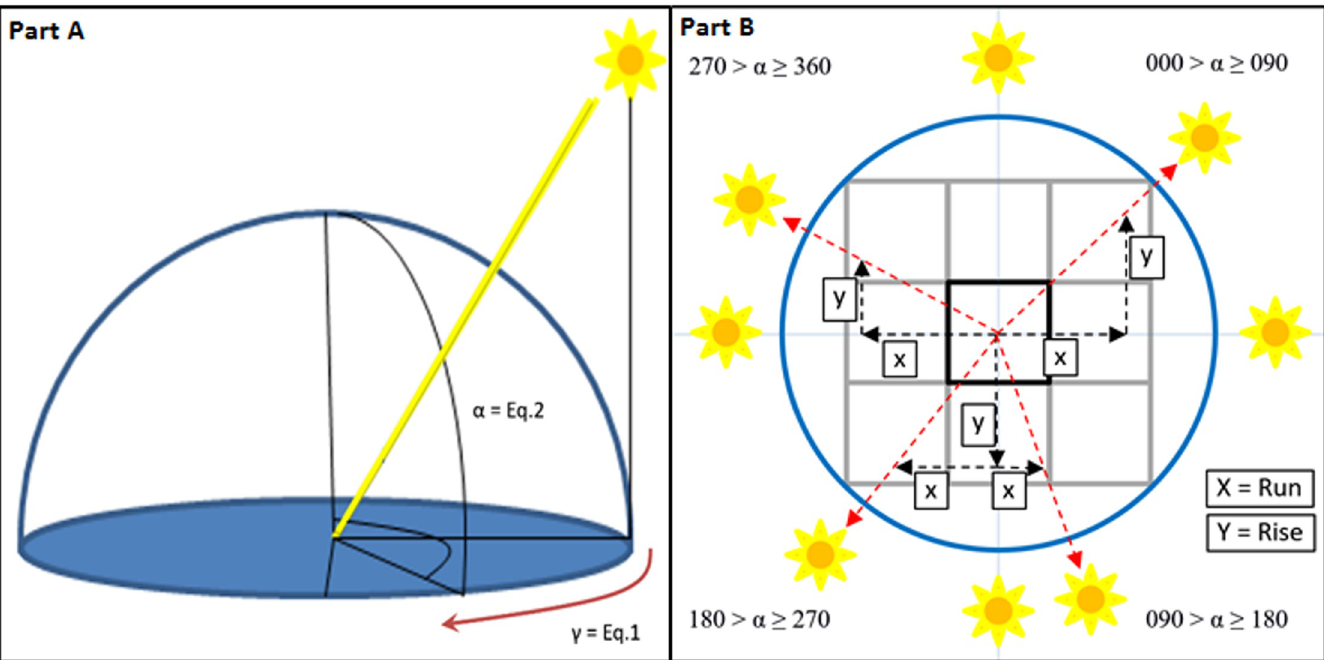
Fig 3. Solar angles and the walking algorithm . Solar azimuth ( α ) and altitude ( γ ) are calculated to control the direction the walking algorithm traverses the landscape. The walking algorithm azimuth rise (Y) and run (X) conversions with example sun positions.